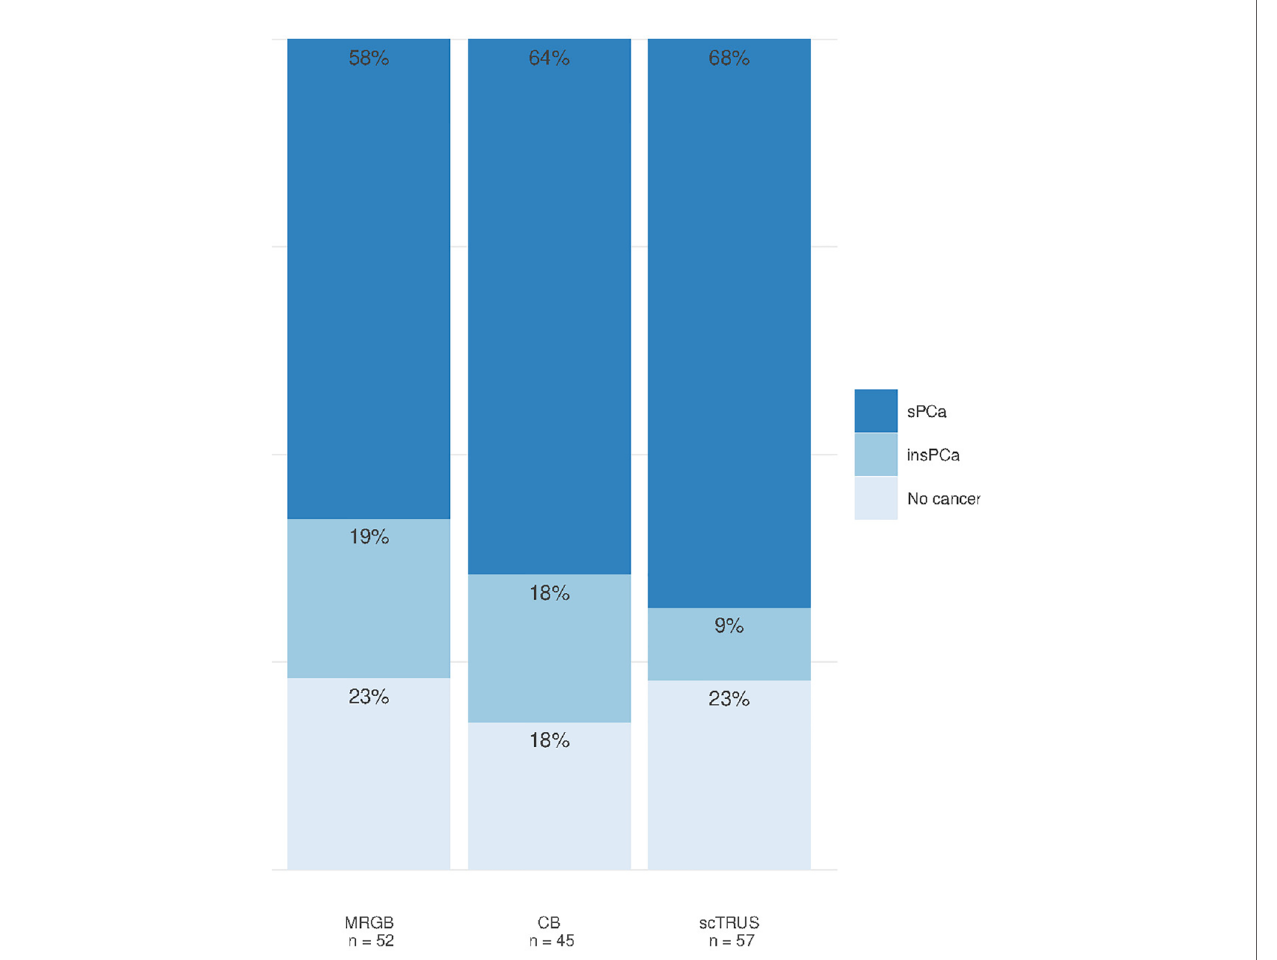
FIGURE 3 | Detection rates of prostate cancer for MRGB, combined biopsy, and cognitive targeted TRUS. MRGB, MR-guided in-bore biopsy. CB, combined biopsy (MRGB with subsequent cognitive targeted TRUS with additional systematic biopsy cores); scTRUS, cognitive targeted transrectal ultrasound-guided biopsy with additional systematic biopsy cores; sPCa, signi fi cant prostate cancer; insPCa, insigni fi cant prostate cancer.